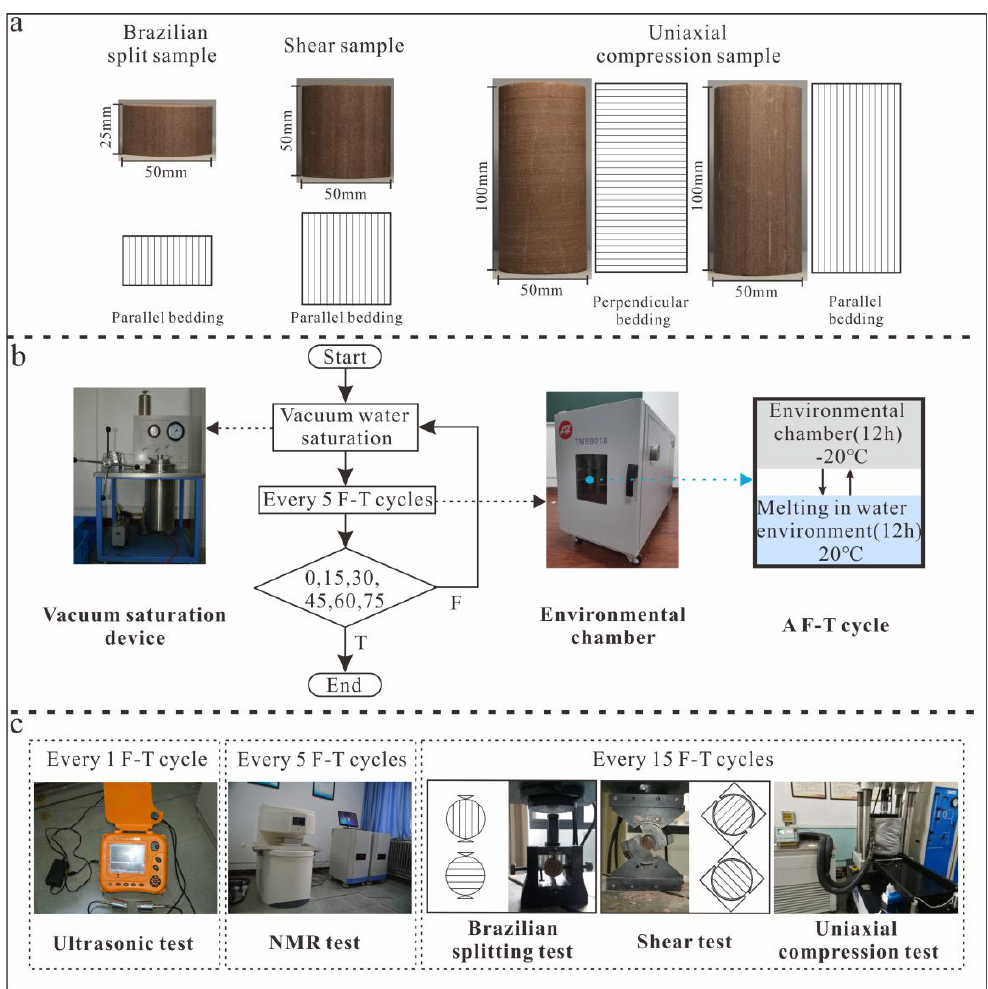
Figure 1. ( a ) Sampling and type of the samples, ( b ) Freeze-thaw cycle test and vacuum saturation, ( c )